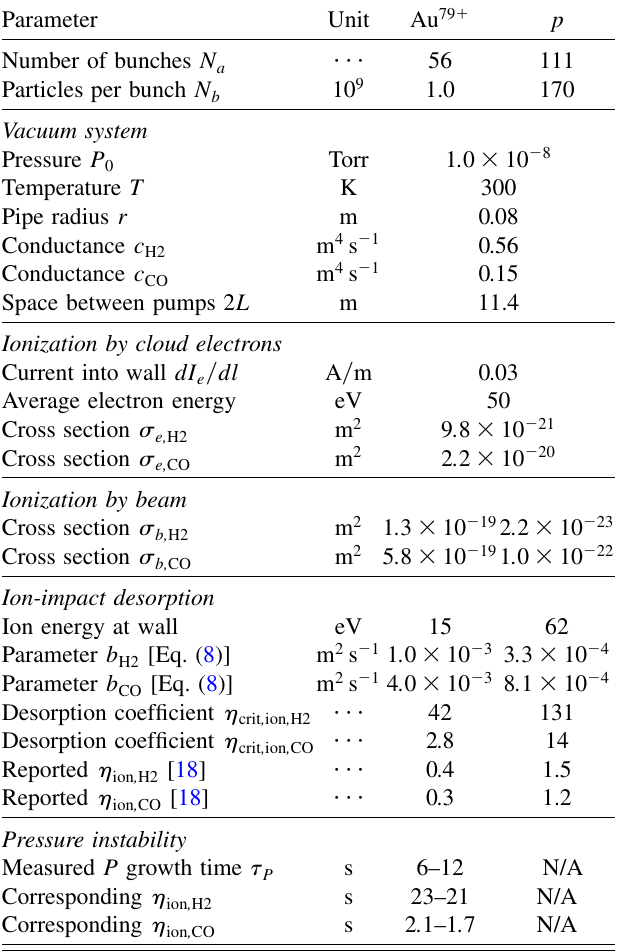
TABLE VII. Estimates for the critical ion-impact desorption for Au ions at store, and p at injection with coefficients (cid:3) crit ; ion the highest injected intensities during the RHIC run in 2004. Pressure instabilities were observed with Au, but not with p .